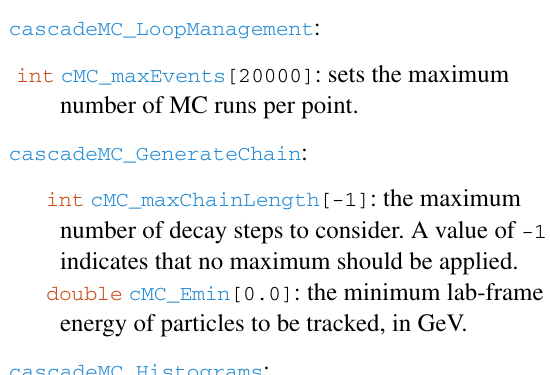
Fig. 5 Gamma-ray spectra from DM cascade annihilation, generated with the DarkBit FCMC. DM particles, χ , annihilate into bosons φ 1 and φ 2 , which decay, respectively, in photon pairs and bottom quark = 100GeV. pairs. For all lines, we assume m χ = 100GeV and m φ 2 = 10 , 30 , 50 , 70 , 90GeV (with the The mass of φ 1 varies between m φ 1 lowest mass corresponding to the magenta line with the pronounced box-like feature on the right)